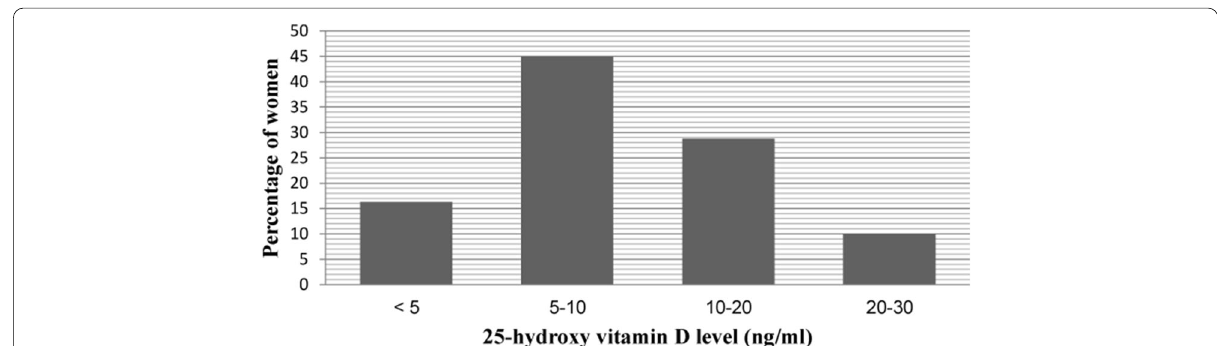
Fig. 1 Vitamin D level of the study population